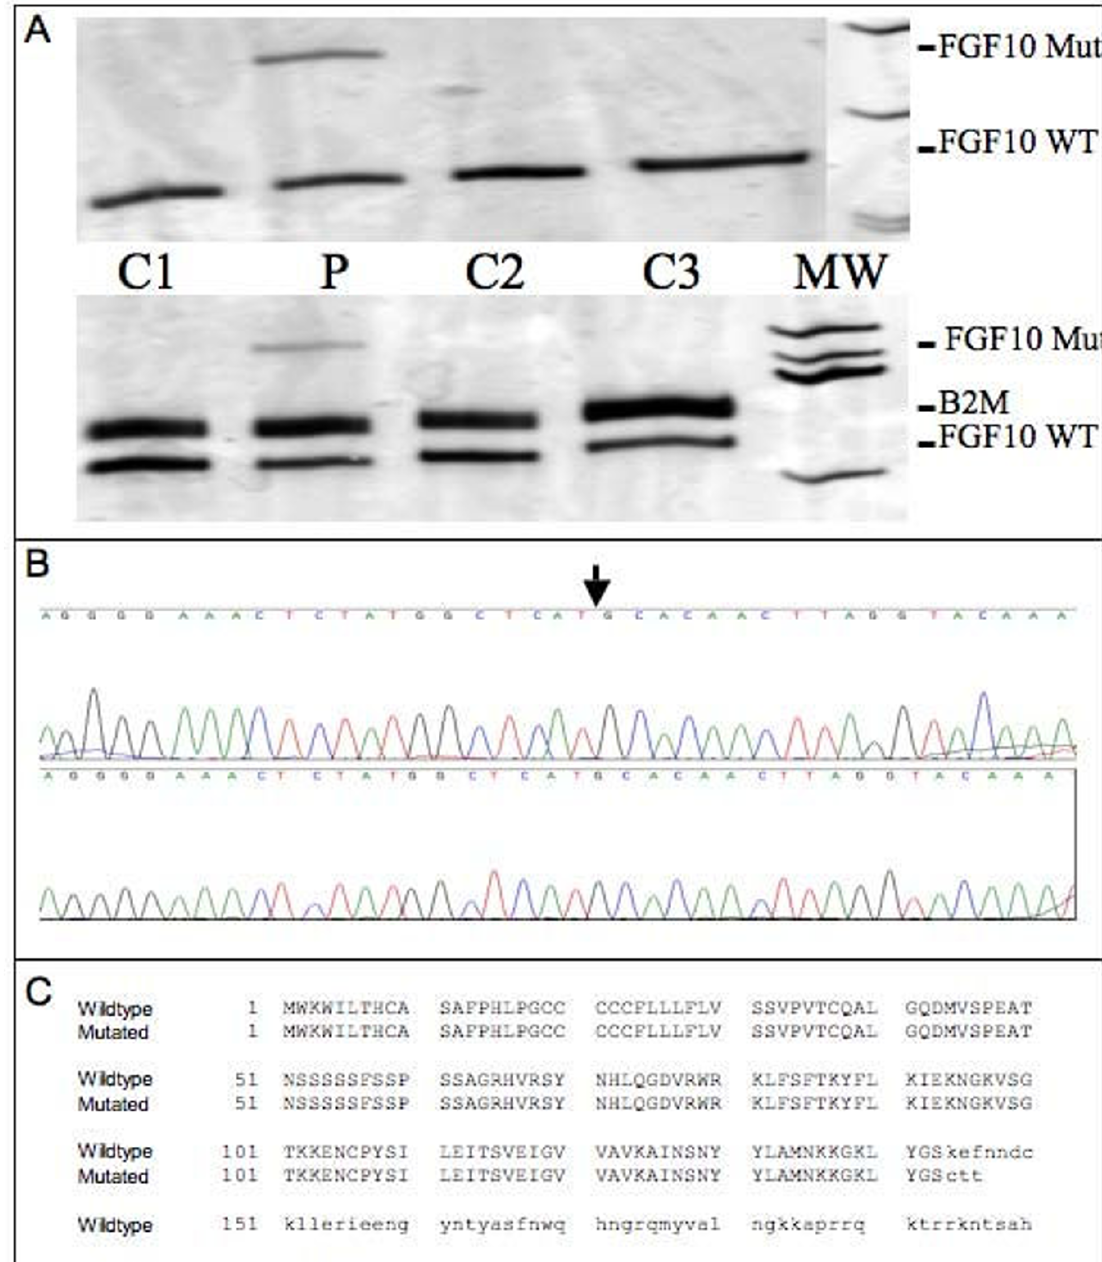
Figure 4 Detection and analysis of an aberrant transcript . 4a: Separation of FGF10 RT-PCR amplificates using sensitive silver- stained polyacrylamid gels reveals additional fragments for the patient's samples but not for control samples. Upper panel, Amplification of the FGF10 transcript using oligonucleotides designed to amplify exon 1 to exon 3 sequences; Lower panel, Amplification of the FGF10 transcript using oligonucleotides designed to amplify exon 2 to exon 3 sequences. C: control; P: patient. 4b: Sequence analysis of the excised and re-amplified additional exon 1/exon 3 fragment. The c.430-1, G > A aberration results in the use of an alternative splice acceptor site 127 bp upstream of exon 3. 4c: Putative effect of the 127 bp insertion on protein